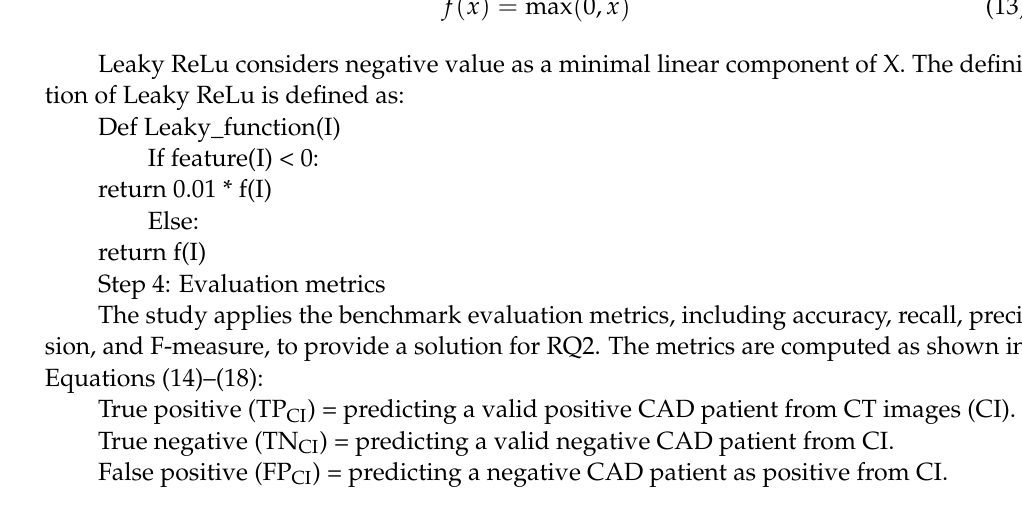
Figure 7. Proposed CNN model.